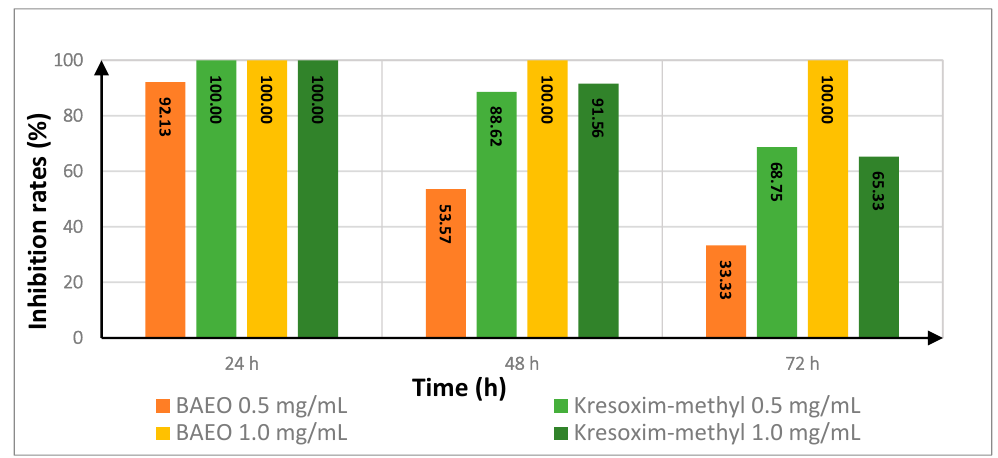
Figure 2. Effect of treatment time on the antifungal activity of BAEO against Fusarium oxysporum f. sp. niveum .